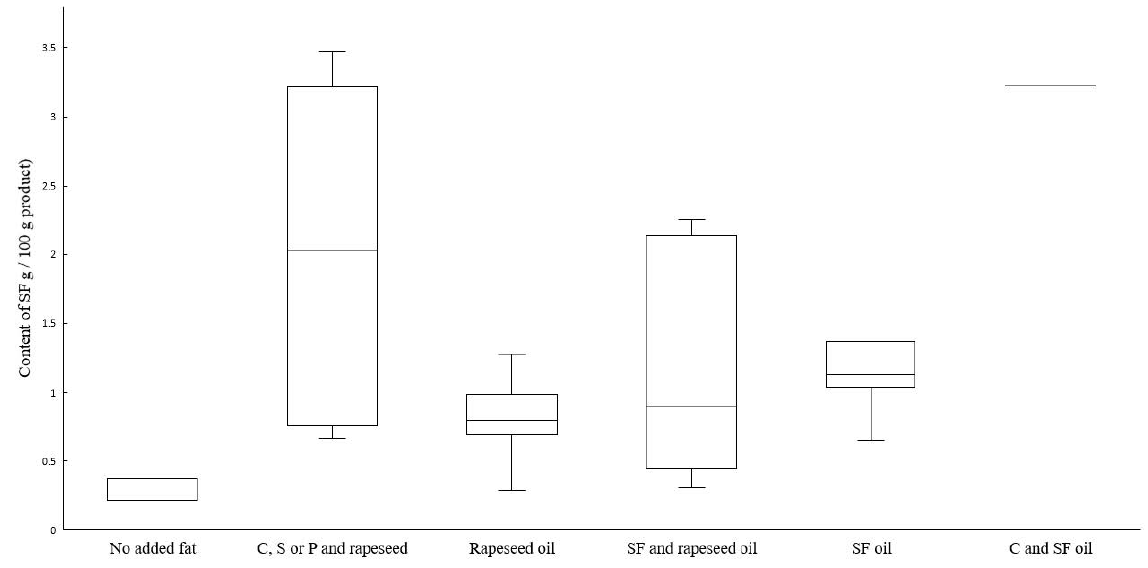
Figure 5. Boxplot of the saturated fatty acid content, sorted and analyzed in meat substitutes based on added fat, as stated on the package. Abbreviations: C, coconut oil; S, shea butter; P, palm oil; SF, sunflower oil. Line inside the box shows the median value, top of each box is the 75th percentile, and bottom of each box is 25th percentile. Whiskers are maximum and minimum values.